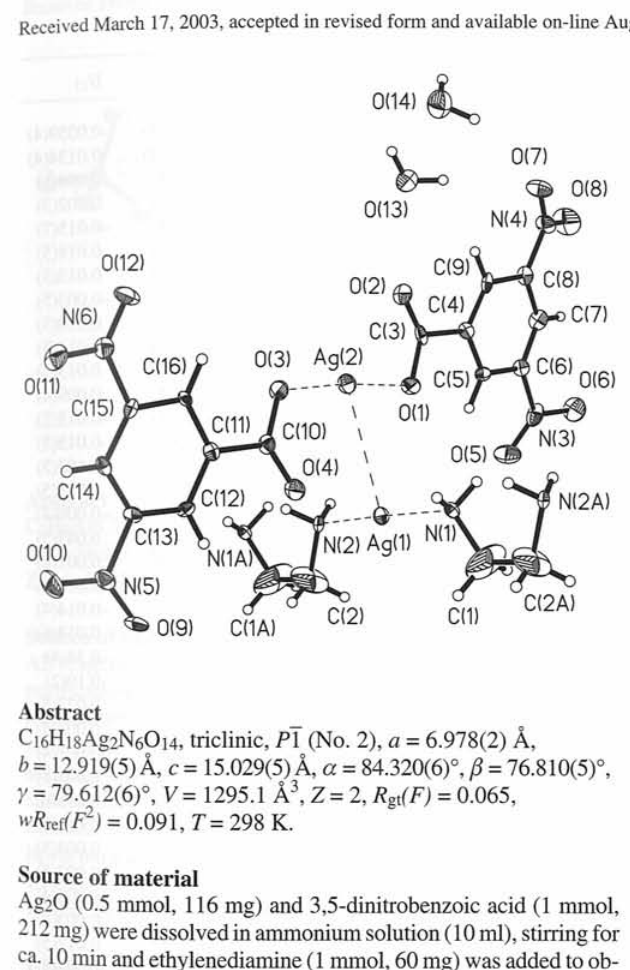
Table 1. Data collection and handling.